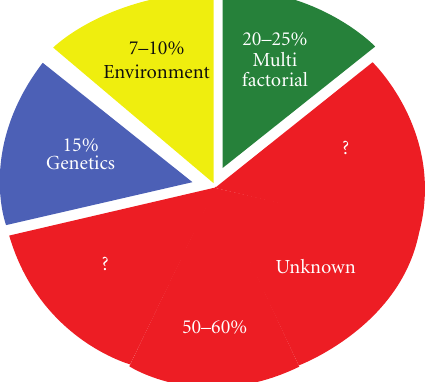
Figure 1: Causes of human congenital abnormalities (adapted from